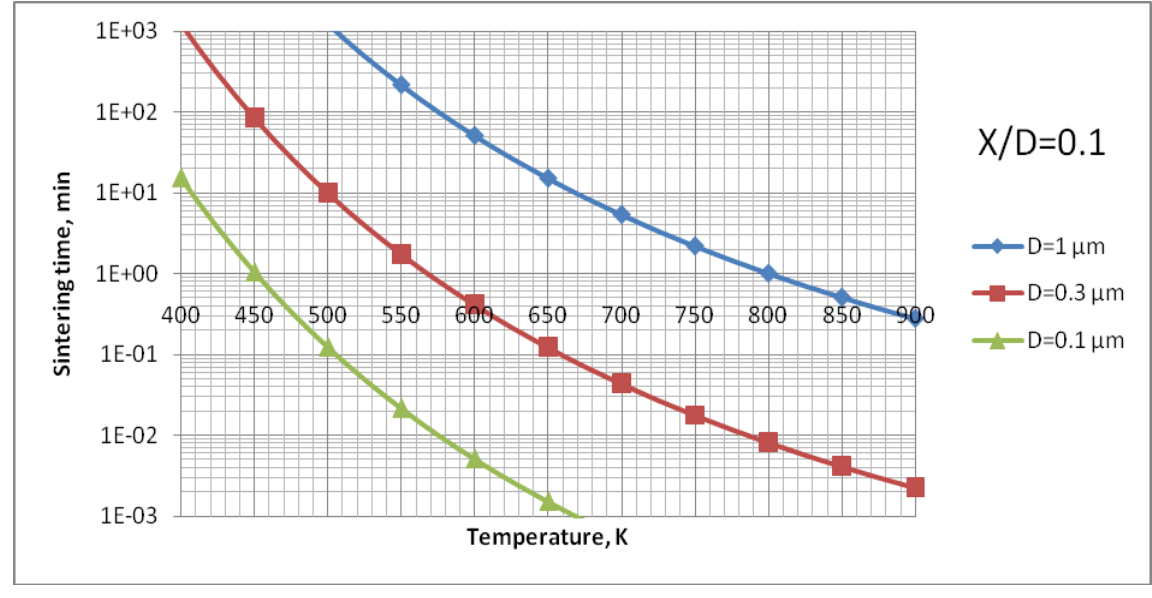
Figure 15. Sintering time of HA particles of initial diameter of D = 0.1; 0.3 or 1 μm to reach the neck size of X / D = 0.1 vs. temperature for surface diffusion mechanism (case of suspension plasma spraying with an internal injector).